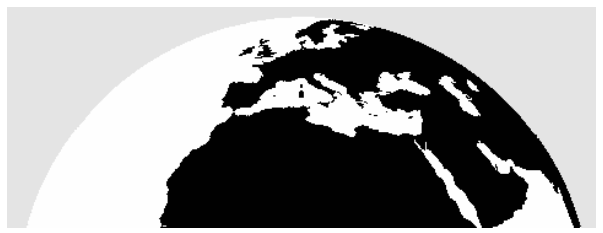
Figure 1. Area covered by the MSG/SEVIRI Rapid Scan